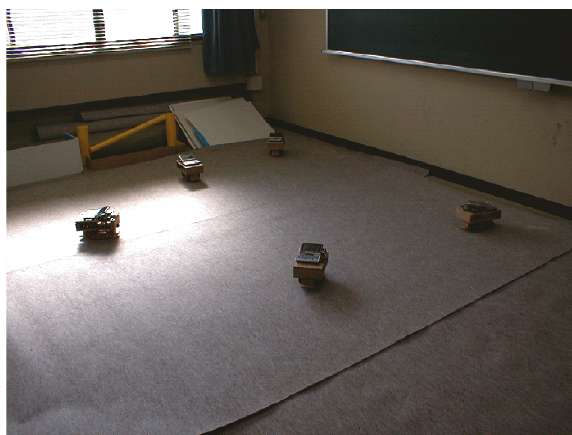
Figure 18: Photograph of an indoor experiment.